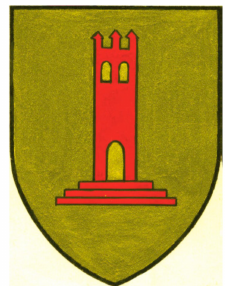
Figure 3. Shield of Torroja’s family “Gold with a gules tower, port and windows in